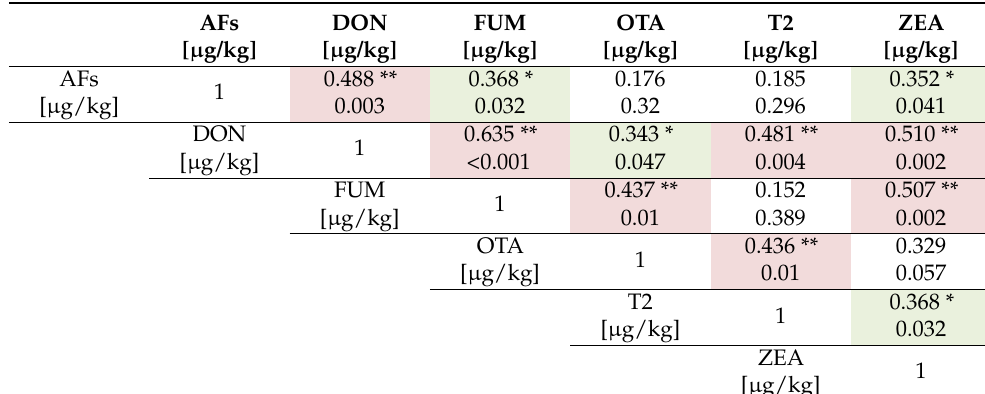
Table 6. Correlation matrix of mycotoxin levels containing Spearman coefficients and two-tailed statistical